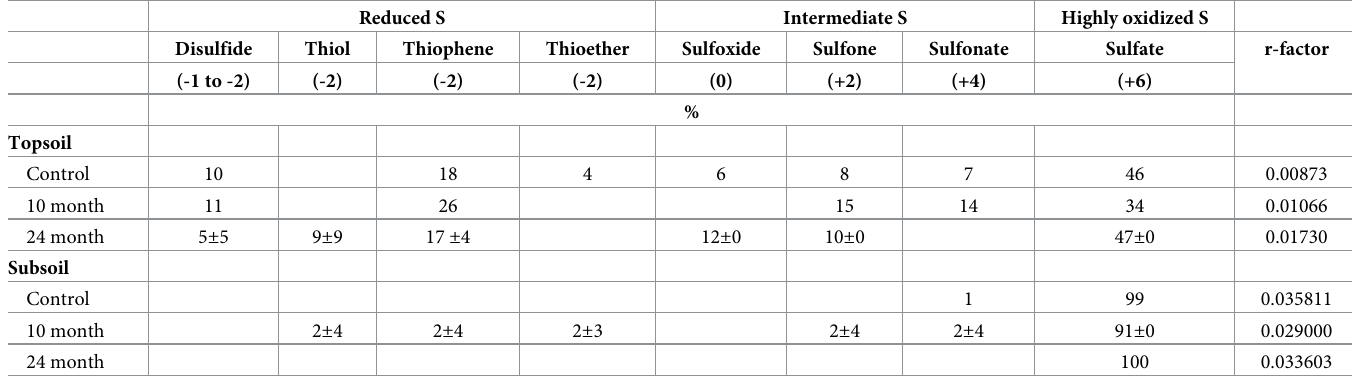
Table 7. Results of linear combination fitting of S K -edge XANES spectra of forest soil microaggregate size fraction of the control without clear-cut, 10, and 24 month after clear-cut. Reference substances: disulfide = Dibenzyl disulfide, thiol = L-cysteine, sulfide = hexakis(benzylthio)benzene, thiophene = dibenzothiophene, sulfoxide = phenylsulfoxide, Thioether = L-methionine, sulfone = dibenzothiophene sulfone, sulfonate = methanesulfonate, sulfate = calcium sulfate dehydrate and oxida- tion state of S in these compounds. Values in brackets shown the standard deviation of averaged fit proportions in the case when fits were not significantly different to each other (Hamilton P � 0.05) based on the